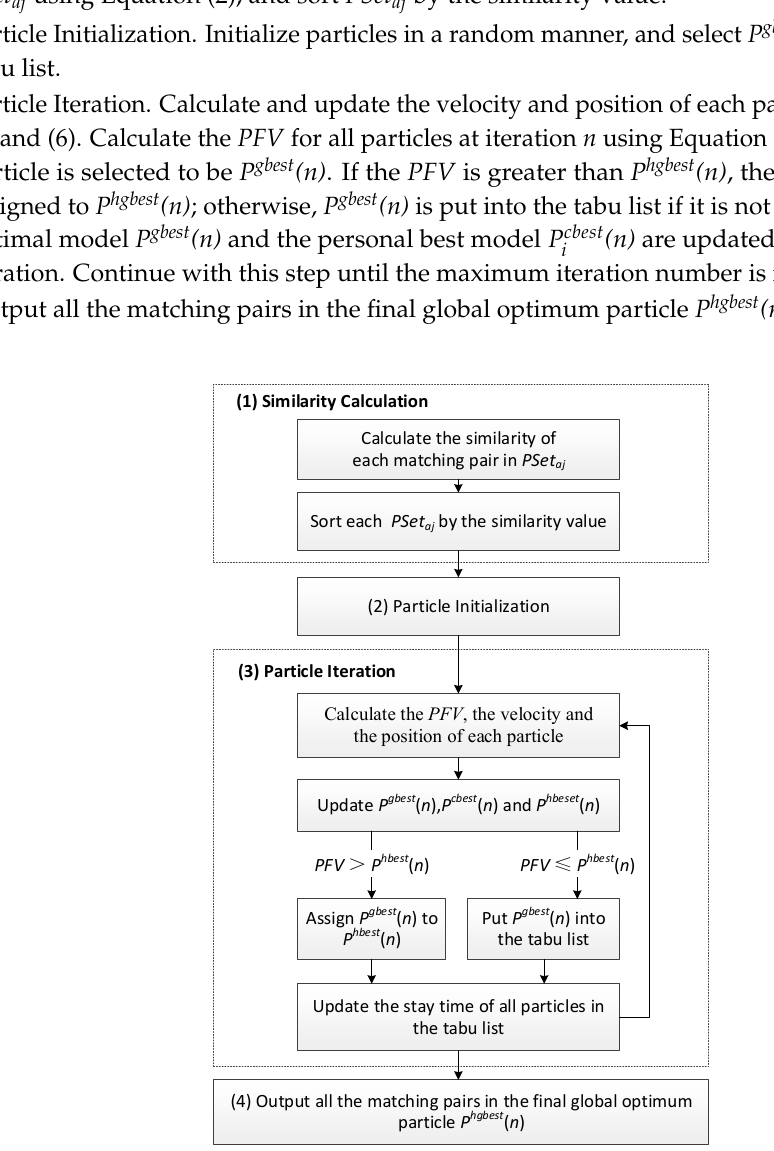
Figure 2. Particle-swarm optimization-based matching (PSOM) workflow.